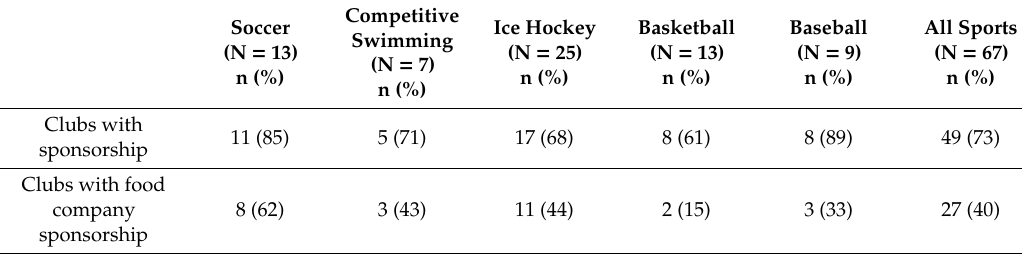
Table 1. Number and percentage of children’s sports clubs in Ottawa (Canada) with sponsorship and food company sponsorship, overall and by sport.